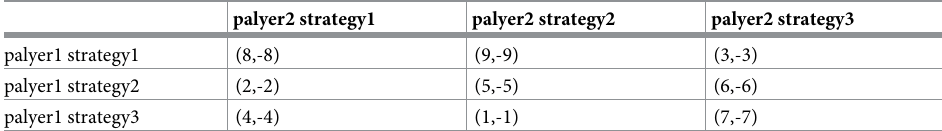
Table 1. Two-person zero-sum game payment function.